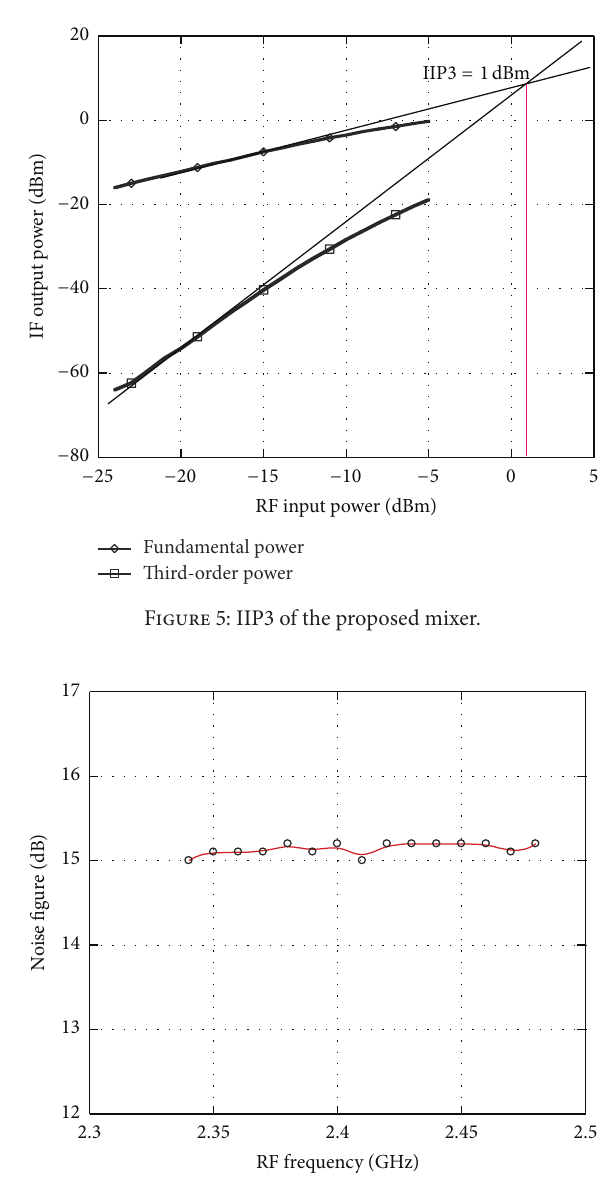
Figure 6: Noise figure.